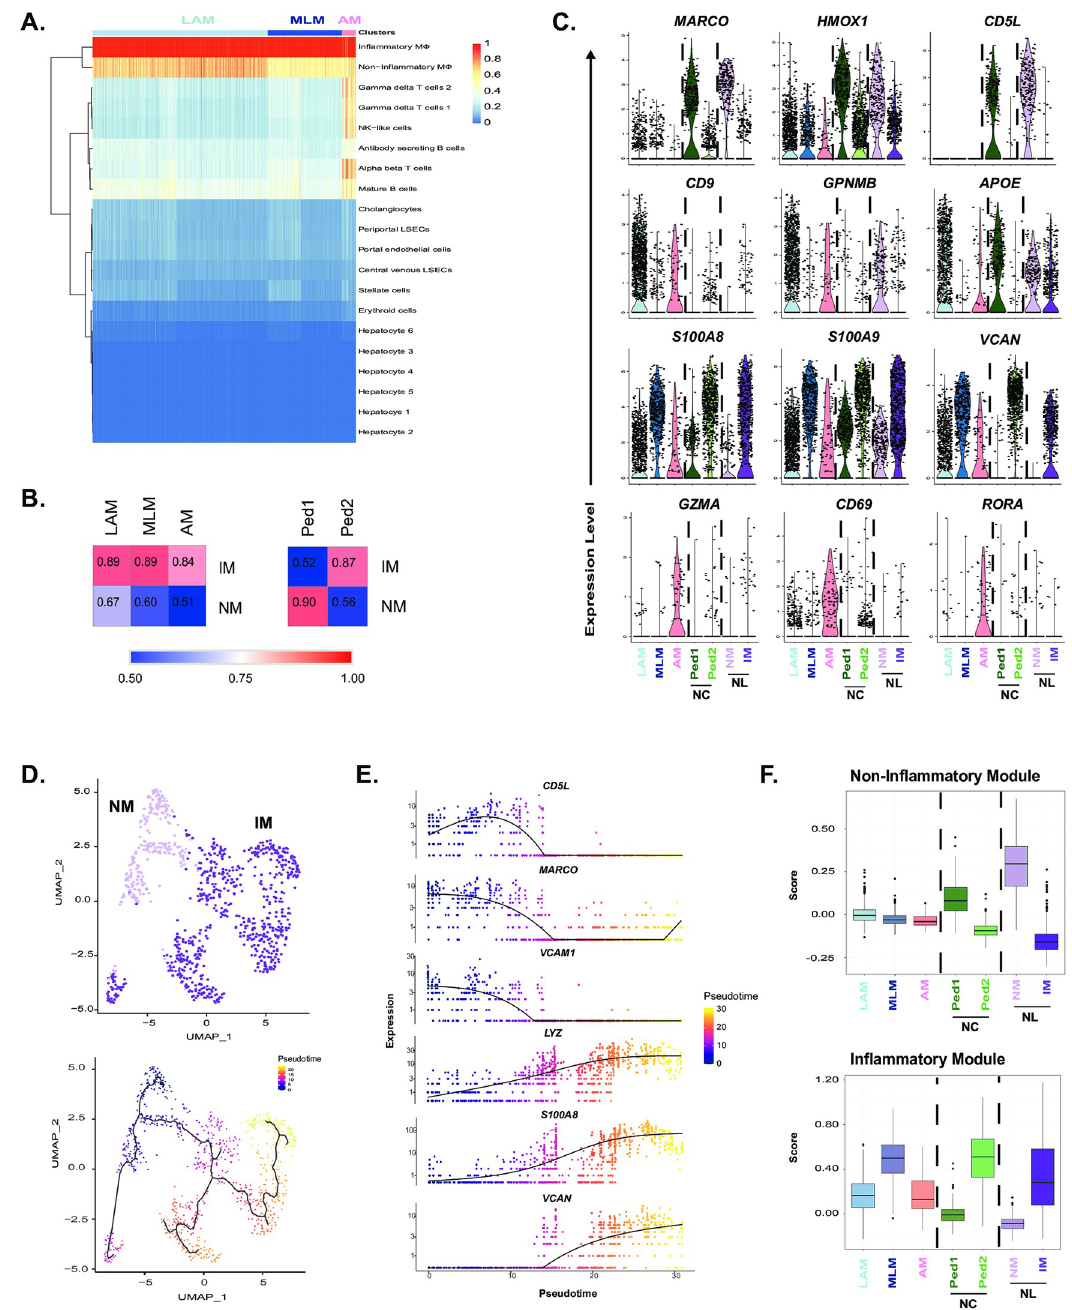
Fig 5. Cholestatic macrophages are distinct from non-diseased hepatic macrophages. All three cholestatic macrophage subsets were primarily assigned by SingleR to previously published inflammatory macrophages (IM) in non-diseased liver (A). The mean gene expression of each cholestatic macrophage subset was more highly correlated with inflammatory macrophages (IM) than non- inflammatory macrophages (NM) (left). Of the two macrophage subsets in pediatric non-cholestatic (NC) liver, Ped1 was most similar to NM, while Ped2 was similar to IM (right) (B). Violin plots of individual genes that define similarities and differences in expression between cholestatic macrophage subsets as compared to healthy adult and pediatric NC macrophages (C). Pseudotime analysis of healthy adult macrophages given a beginning (indicated with black circle) at NM (light purple) inferred a trajectory ending in IM (dark purple) (D). The non-inflammatory module contained genes with expression peaking at pseudotime 0–5, while the inflammatory module peaked at pseudotime 20–25 (E). The non-inflammatory module is lowly expressed across all cholestatic macrophages whereas MLM demonstrated high expression of the inflammatory module (F).